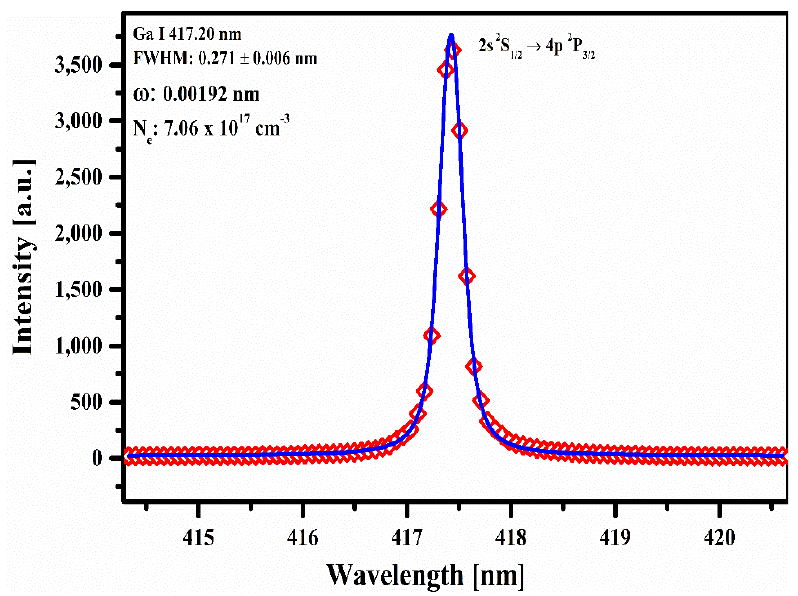
Figure 4. A typical Stark-broadened line profile of Ga I at 417.20 nm along with the Voigt fitting profile.